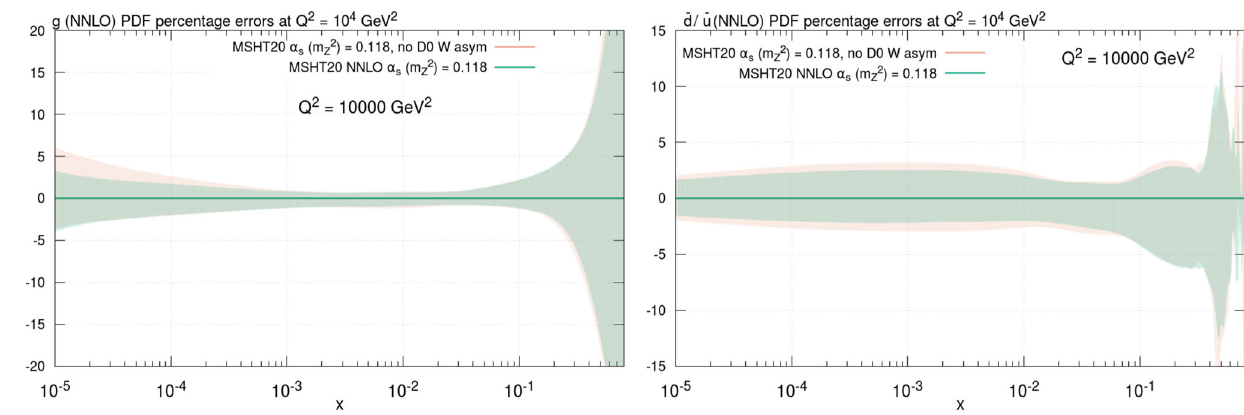
Fig. 62 (Left) g and (right) ¯ d / ¯ u PDF percentage errors at Q 2 = 10 4 GeV 2 at NNLO in both the MSHT20 default fit and the same with the removal of the DØ W asymmetry data, and without fitting the electron asymmetry